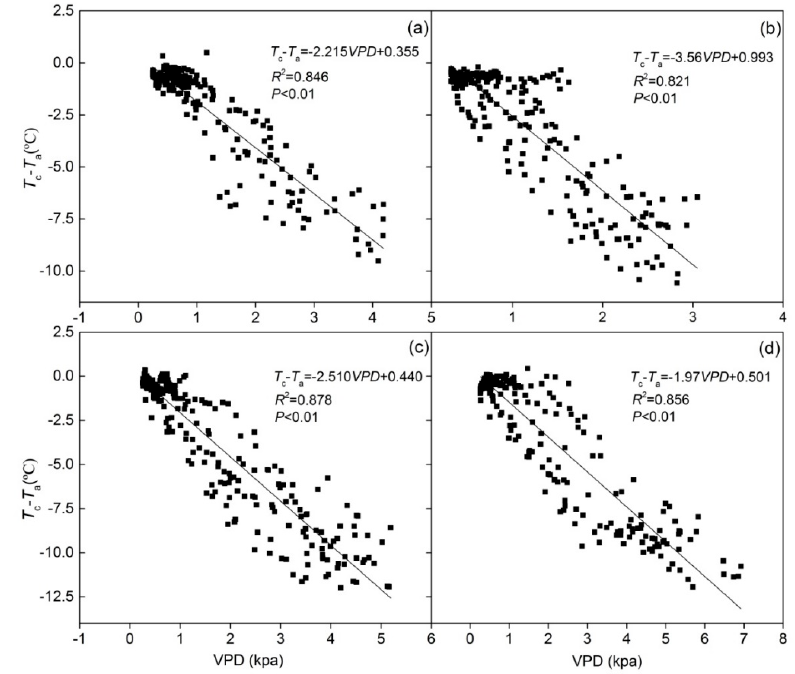
Figure 4. NWSB of the CWSI at different stages: ( a ) represents the vegetative stage, ( b ) represents the flowering stage, ( c ) represents the fruit expansion stage, and ( d ) represents the mature stage. Horticulturae 2020 , 6 , x FOR PEER REVIEW